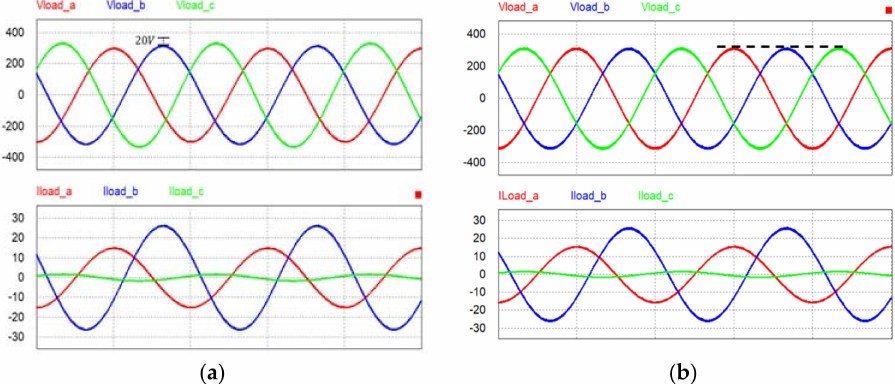
Figure 20. Simulation results of resonant controller under an unbalanced load. ( a ) Conventional controller; ( b ) Resonant controller.